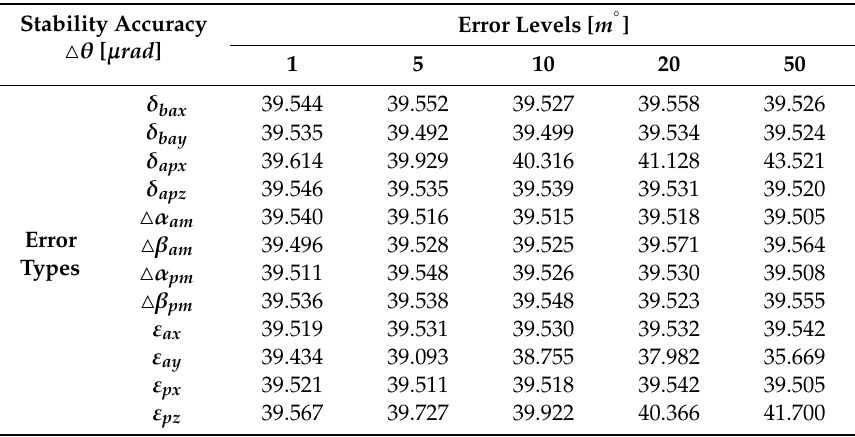
Table 3. Simulation results under BD Dis of 1.5